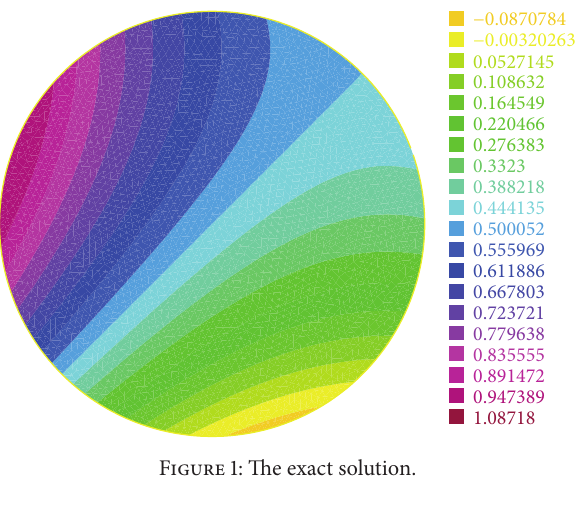
Figure 1: The exact solution.